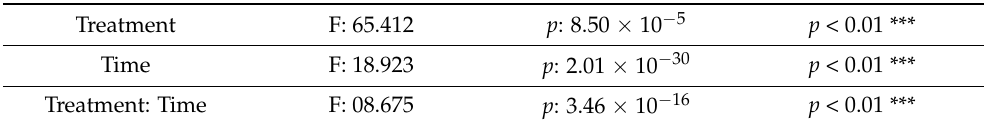
Table 3. Results of repeated measures ANOVA of Festuca rupicola cover. Asteriks indicate statistical significance.